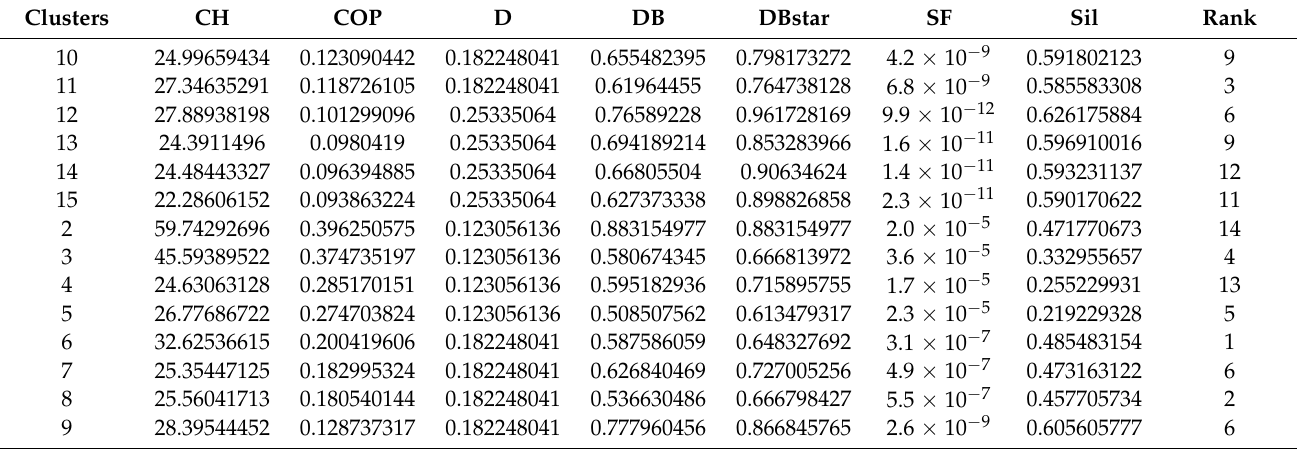
Table 8. CVI results for males aged over